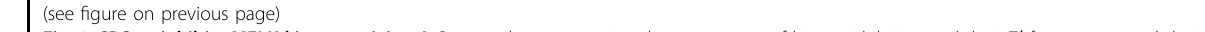
Fig. 3 CRO15 inhibits MELK kinase activity. A Scatter plot representing the percentage of kinase inhibition and their Z ′ factor measured during two independent in vitro kinome assay with 1 μ M CRO15. B Immuno fl uorescence pictures of CT26 cancer cells treated with 5 μ M CRO15 for 2 h. MELK was labeled with a speci fi c antibody (in red), CRO15 was coupled to a fl uorescent tag (in green) and nuclei were stained with DAPI (in blue). C In vitro test of kinase activity using recombinant MELK protein treated with CRO15 with the MELK inhibitor OTS167. D A375 cells were infected with MELK adenovirus for 24 h. For the pull down assay, cells lysates were incubated overnight with 100 μ M Biotin-CRO15 or its inactive analog MTF465. For Biotin precipitation, cells were treated for 2 h with 20 μ M Biotin-CRO15 or MTF465 before lysis and western blot analysis with the indicated antibodies. One representative experiment of three is shown. E and F A375 cells were treated with 5 μ M CRO15 with the indicated durations, and lysates were analyzed by western blotting using the indicated antibodies. One representative experiment of three is shown. G A375 cells were transfected with siRNA directed against AMPK α 1 and AMPK α 2 (20 nM each) or 40 nM of control siRNA. Twenty-four hours later, cells were infected with a MELK adenovirus or a control adenovirus before treatment with 5 µM of CRO15. After 24H, viable cells were counted using the trypan blue dye exclusion method ( n = 3) (right panel). In parallel, cell lysates were analyzed by western blotting with the indicated antibodies (left panel). One representative experiment of three is